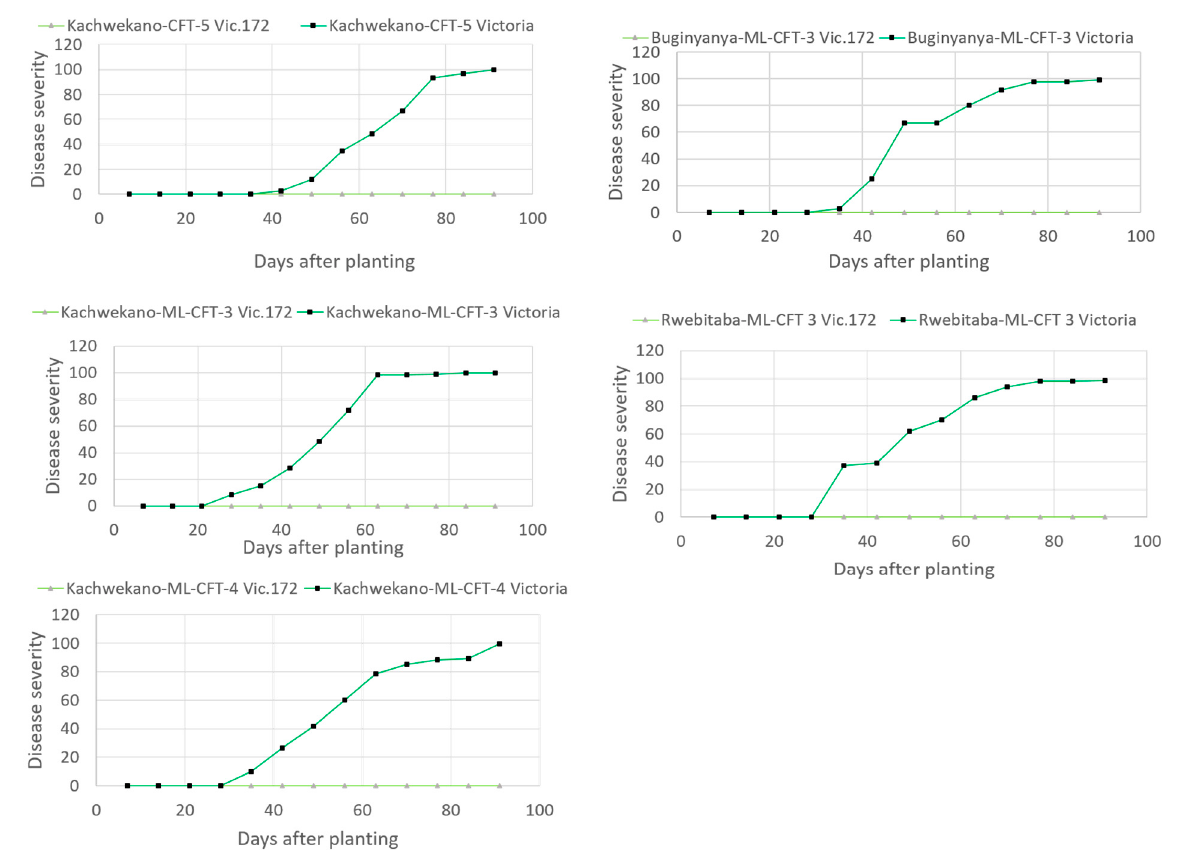
Figure 3. Disease progress curves of the transgenic event Vic.172 (light green) and the variety Victoria (green) at Kachwekano ZARDI during the first season of 2019 (Kachwekano-CFT-5); Buginyanya ZARDI, Kachwekano ZARDI and Rwebitaba ZARDI during the second season of 2019; (Buginyanya-ML-CFT-3, Kachwekano-ML-CFT-3, Rwebitaba-ML-CFT-30); and at Kachwekano ZARDI during the third season of 2020 (Kachwekano-ML-CFT-4). Efficacy trials were conducted without any fungicide treatment.